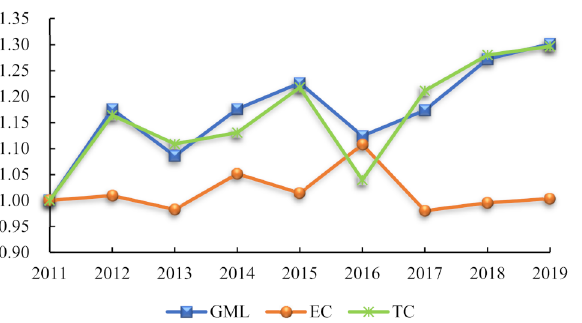
Figure 4. The GML index and its decomposition of tourism efficiency in Gansu Province from 2011 to